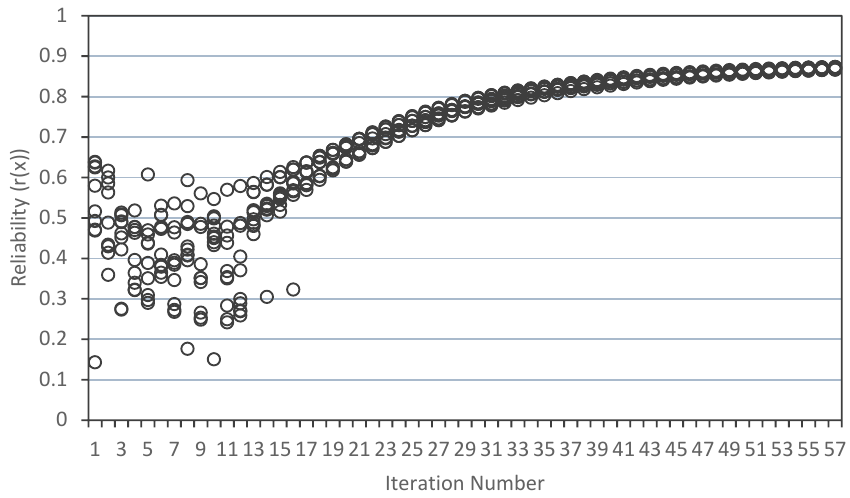
Figure 15. Convergence trend for the parameter t d .